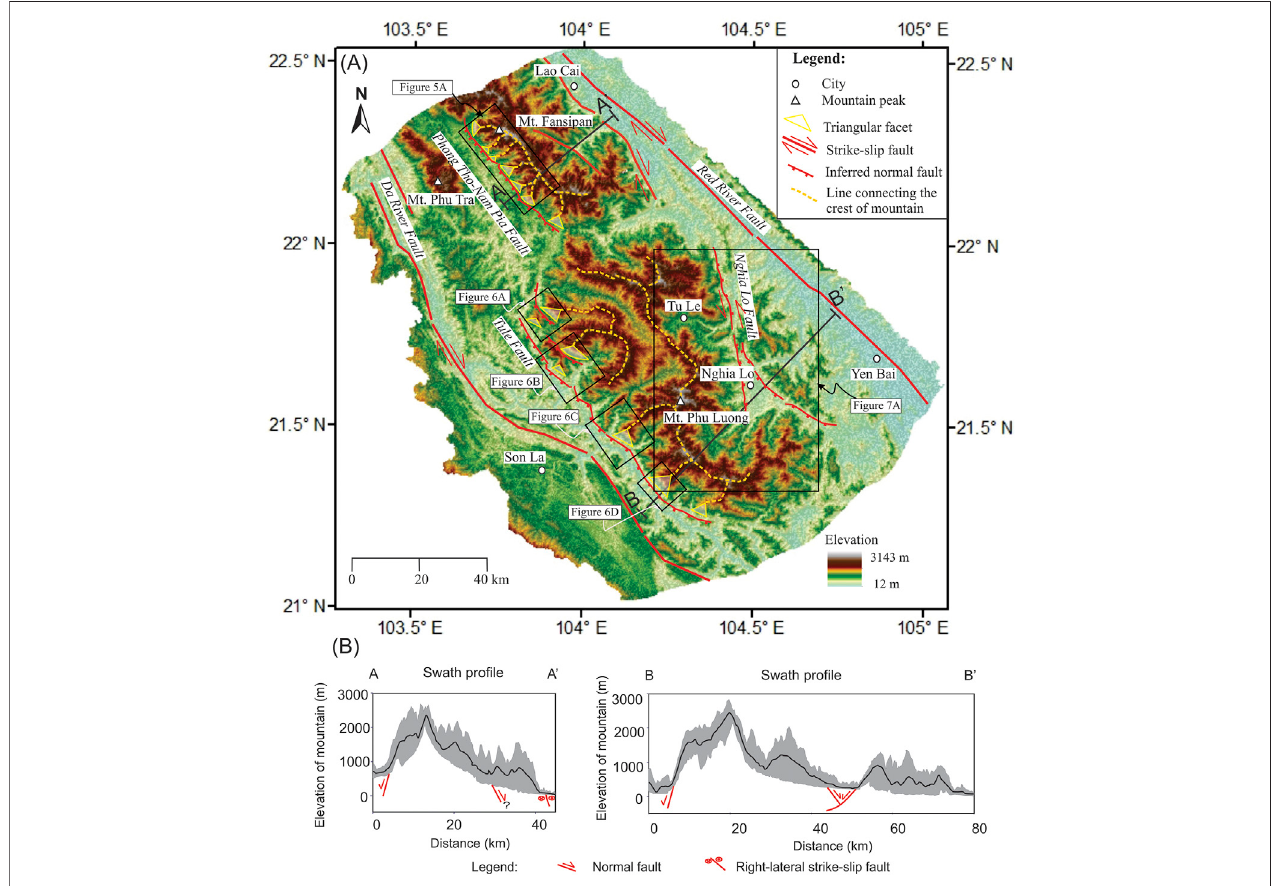
FIGURE 3 | (A) Topographic map showing drainage network, major active strike-slip faults complied from literature, and possible active normal fault inferred from topographyand fi eldobservations.Thinbluelinesindicateriversystem.Yellowtrianglesrepresenttriangularfacets.Dashedorangelineisthelineconnectingthecrestsof the mountain ranges. Red line with directions indicate active strike-slip fault. Red lines with barbs represent the inferred normal faults. (B) Swath pro fi les with the strip width of 10 km on the cross-section lines A-A ′ and B-B ’ .